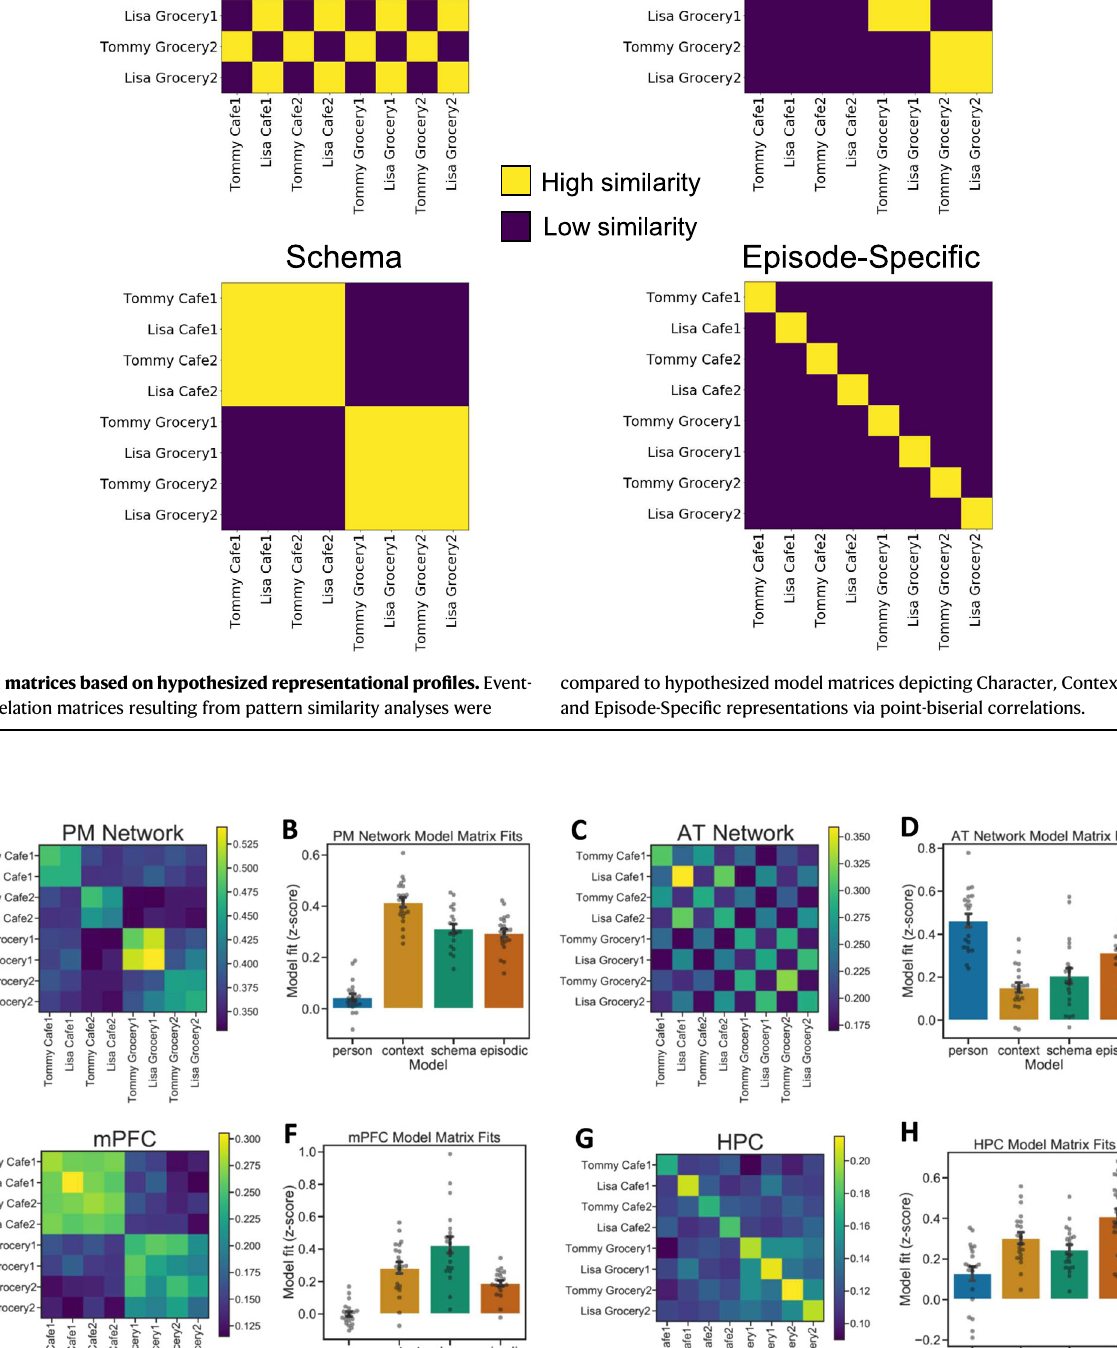
pattern similarity results most strongly fi t the Schema model matrix. G , H HPC pattern similarity results most strongly fi t the Episodic model matrix. ( N =20 par- ticipants, data presented as mean values±SEM).